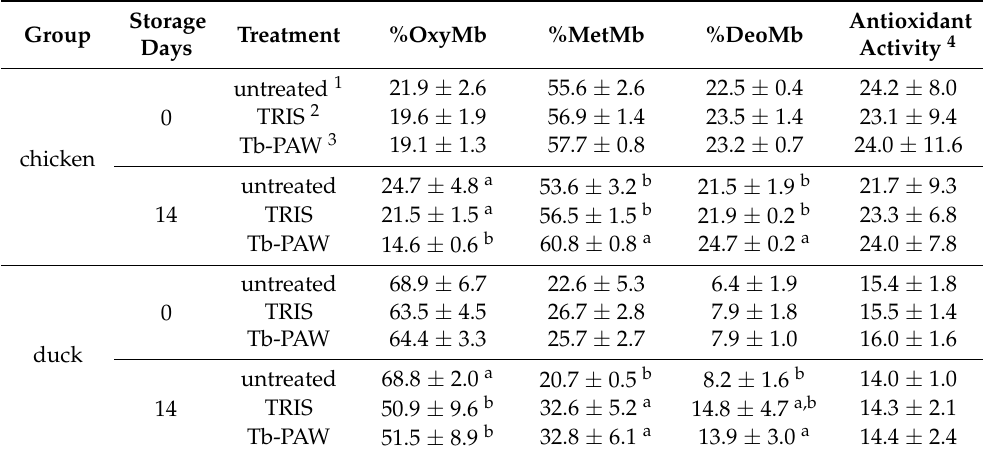
Table 3. Percentages of oxymyoglobin (OxyMb), metmyoglobin (MetMb), and deoxymyoglobin (DeoMb) and the antioxidant activities of chicken and duck breast meat, treated on the skin above the meat with or without Tb-PAW or TRIS-buffer, depending on the day of storage (0, 14) in